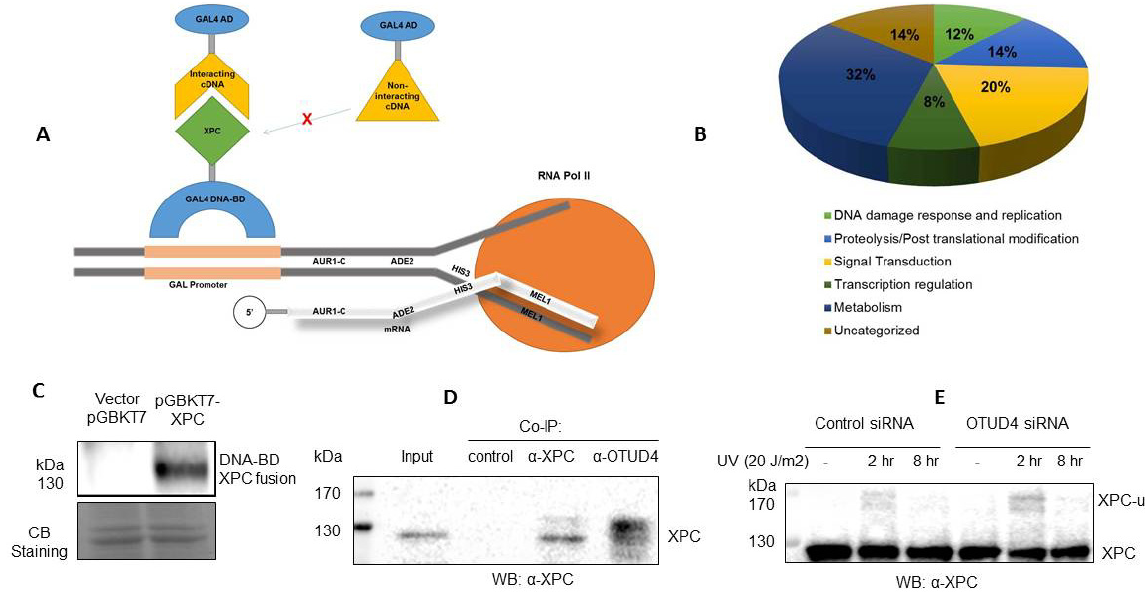
Figure 1. Schematic of the Yeast Two-Hybrid screening performed ( A ). The proximity of the DNA-BD and AD domains from the bait-prey interaction results in the transcription of four independent reporter genes (AUR1-C, ADE2, HIS3, and MEL1). See text for details; ( B ) Categorical organization of interactors of XPC identified by the yeast two-hybrid screening; ( C ) Confirmation of GAL4 DNA-BD-XPC fusion expression in yeast. Western blot was performed using an anti-XPC antibody (Cell Signaling). Coomassie blue (CB) staining was used as loading control; ( D ) Co-immunoprecipitation (Co-IP) to validate OTUD4-XPC interaction identified by the yeast two hybrid screening. HCT116 cell extracts were incubated with no antibody control, an XPC antibody, or an anti-OTUD4 antibody, respectively. Interacting proteins were collected by protein A/G beads and separated on a SDS-PAGE gel. Western blot was performed using a XPC antibody; and ( E ) Functional link between the OTUD4 deubiquitinase and XPC ubiquitination. Elevated levels of UV-induced XPC ubiquitination were detected in HCT116 cells with OTUD4